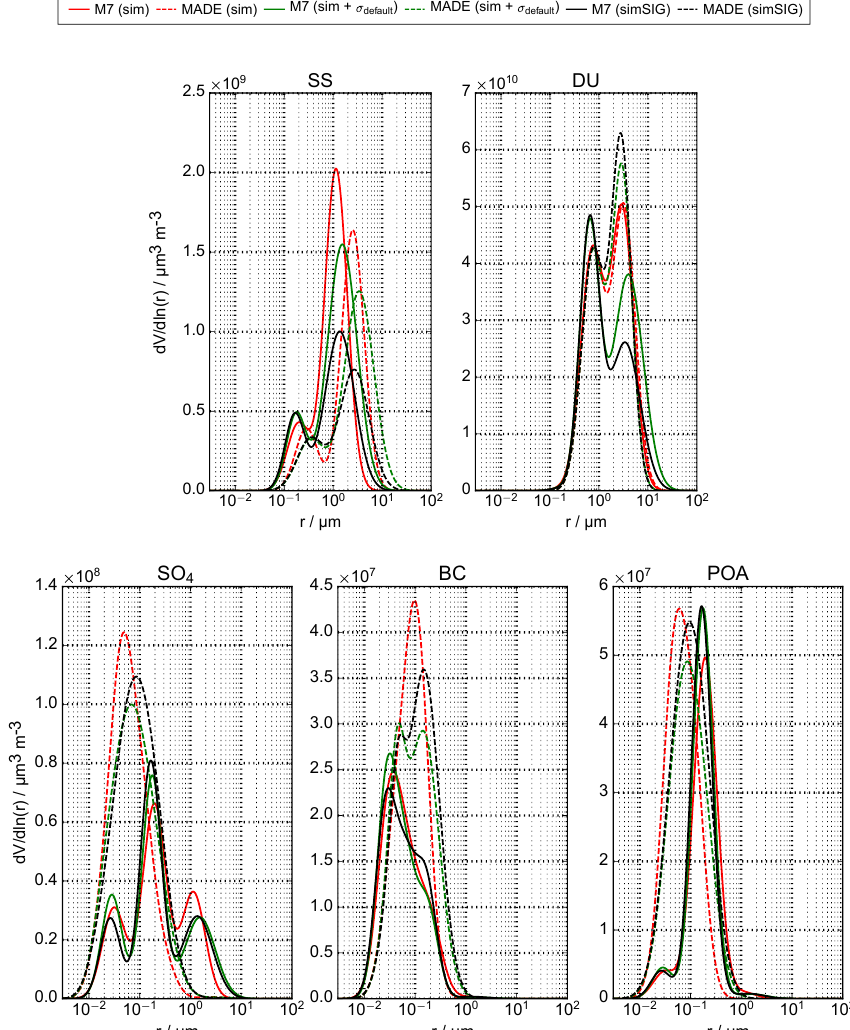
Figure 5. Domain-averaged volume distributions for different species and standard deviations. Species include SS, DU, sulfate (SO 4 ), BC Figure 5: Domain-averaged volume distributions for di  erent species and standard devia- and POA. Individual lognormal modes are determined from the vertical sum and horizontal average of the corresponding dry masses and tions. Distributions are obtained by weighting the total dry volume distribution by the fraction the numbers. The full, multimodal distribution emerges as the sum of individual lognormal modes. For mixed modes, lognormal modes of respective species contributes to the total mass. The total distribution is the sum of all model modes, individual species are obtained by weighting the mixed-modal distribution by the fraction that the respective species contributes to the total which are determined from the vertical sum and horizontal averages of the corresponding dry masses mass in the mixed mode. The figure compares sim simulations, generated with the universal standard deviation σ universal = 1 . 7 for all modes and numbers. Species include sea salt (SS), dust (DU), sulfate (SO 4 ), soot (BC) and primary organic carbon (POA). The figure compares simulationssim, generated with the universal standard deviation (red), sim simulations but plotted using default standard deviations σ default as given in Table 1 (green), and simSIG simulations, generated ‡ universal = 1.7 for all modes (red), simulationssim but plotted using default standard deviations ‡ default with σ default as given in Table 1 (green) and simulationssimSIG , generated with ‡ default (black). 17